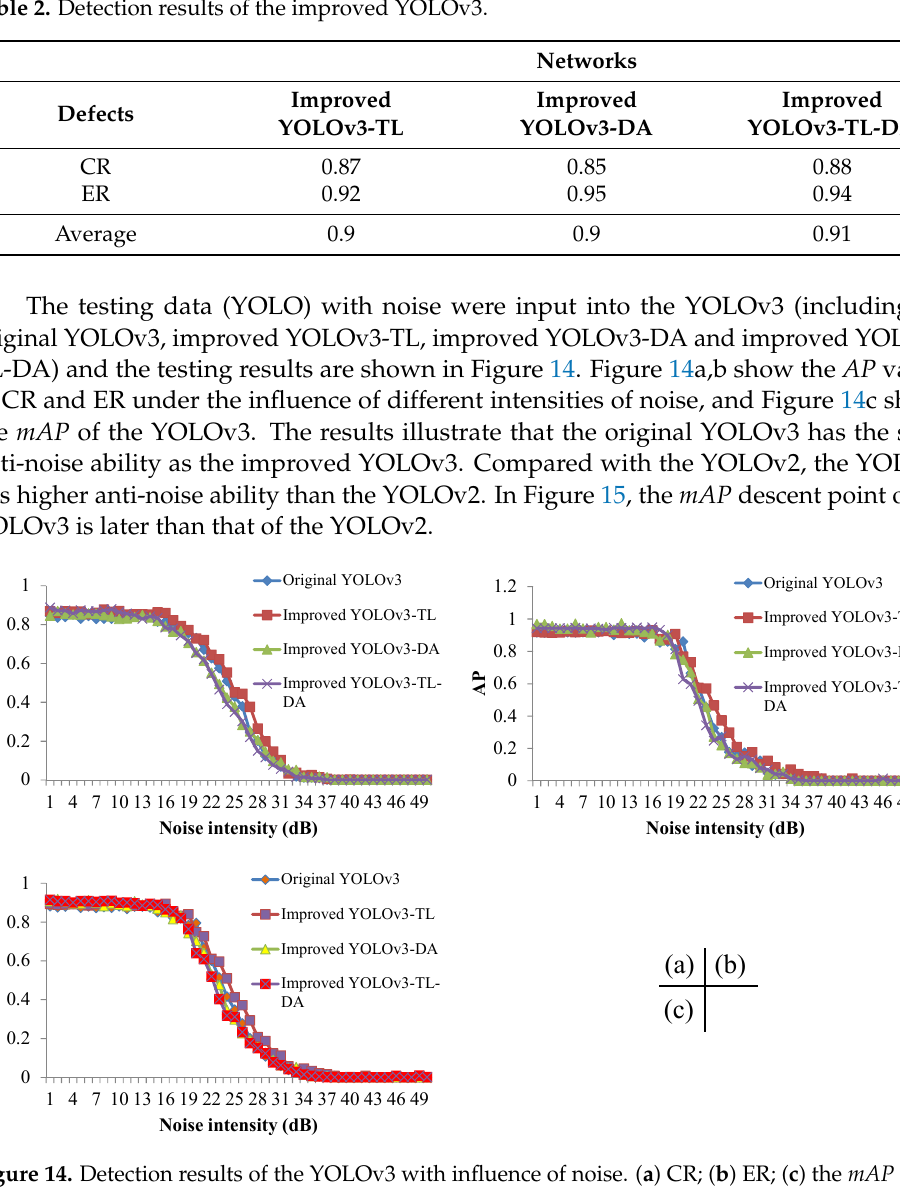
Table 2. Detection results of the improved YOLOv3.